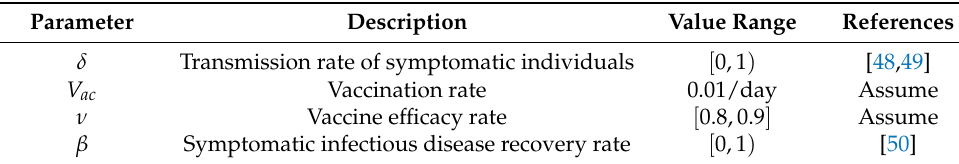
Table 1. Descriptions of model (1)’s variables and